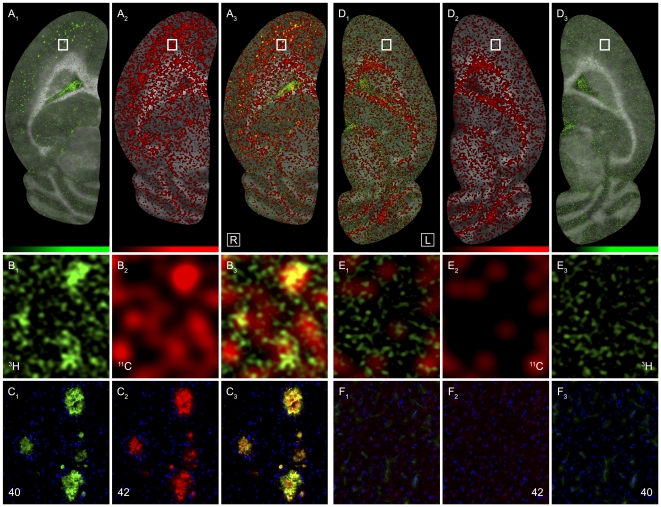
Multi-modal combined experiment.Single multi-modal in vivo/ex vivo combination experiment with 4 animals from the young study groups (2 tgtg-young and 2 ctl-young) showing the whole spectrum of results on an individual level. After a bolus injection of a [11C]PiB/[3H]PiB cocktail, the animals passed a 30 min CT/PET scan, were then killed for immediate [11C]PiB regional brain biodistribution and dual-label digital autoradiography. Brain halves used for biodistribution were analyzed for Aβ protein levels. The other brain halves were stained with Thioflavin S and anti-Aβ40/42 and used for histological plaque quantification. Columns (1) to (3): 9 month old female homozygous APP/PS1 mouse (“AD1”) and Column (4) to (6): 9 month old female C57BL/6J control mouse (“CTL1”), presented in a mirror fashion. Ex vivo [11C]PiB (red)/[3H]PiB (green) dual-label digital autoradiographs with underlying optical scans of horizontal 12 µm half brain sections of AD1 (right brain) (A and B) and CTL1 (left brain) (D and E) (marked with asterisk (*) in Table 3) and corresponding magnified views of double immunofluorescence stains for Aβ40 (green) and Aβ42 (red) of neighboring sections for the same region (C and F). All four modalities are shown individually (outer two columns) and co-localized (central columns). Limits of green and red color look-up-tables represent minimum and maximum of measured signal. The analytical results of all experiments are shown in Table 3 below this figure.